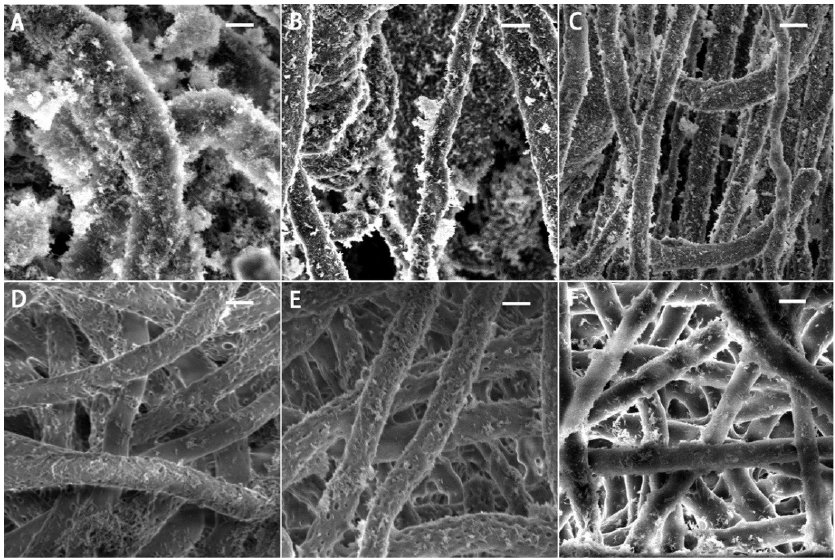
Figure 6. SEM of PDLLA/nHA composite fibrous membranes with different nHA content. Scale bars represent 1 μm. Table 1. nHA content of PDLLA/nHA composite fibrous